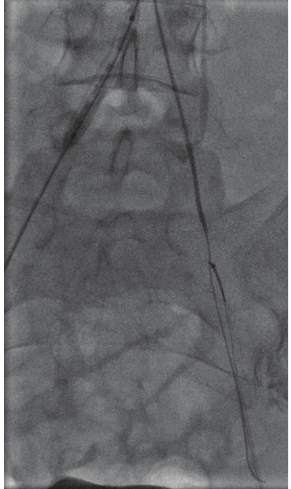
Figure 5: Wire retrieval from the left femoral sheath following recanalization of the left common iliac artery.